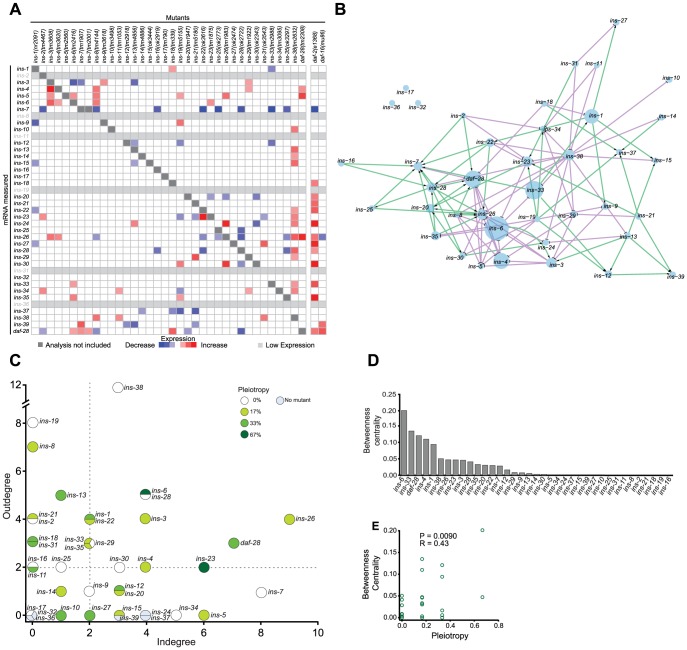
The ILP regulatory network.(A) Heat map summarizing the significance and direction of expression changes for all ILP mRNAs in 36 ILP mutants represented by negative log of the p-values. Significant differences (q<0.05) and transcripts with low expression were colored as indicated in the legend; more significant changes are more darkly shaded. Transcripts corresponding to deleted ILPs were excluded because these changes were not due to regulation (see Table S5 for mRNA changes). (B) Gene expression network based on a spring-embedded layout. Node sizes reflect the magnitude of betweenness centrality. Green and violet lines indicate excitatory and inhibitory connections, respectively. (C) A scatter plot of inputs versus outputs for each ILP. Pleiotropy signifies the percentage of phenotypes affected by each ILP; dauer entry phenotypes were aggregated for this purpose (see Materials and Methods and Figure 1). Dashed lines indicate the median for each axis. (D) Rank order of the ILPs for betweenness centrality. (E) Scatter plot showing linear correlation of betweenness centrality with pleiotropy.